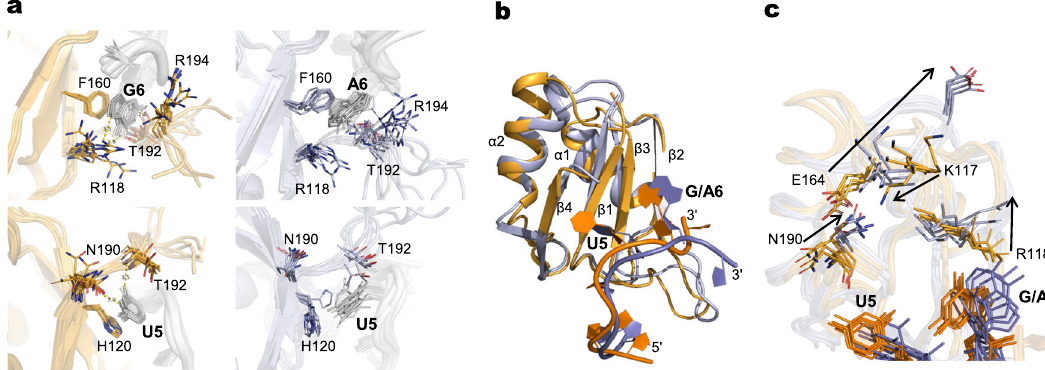
Fig. 6 | Comparison of RbFox RRM structures with 5 ’ -UGCAUGU and 5 ’ - UGCAUAU. a Recognition of G6/A6 (upper panel) and U5 (lower panel) by RbFox RRM (left: 5 ’ -UGCAUGU; right: 5 ’ -UGCAUAU). Side chains of key residues in the interactions (sticks) are labeled. b Comparison of the two RbFox-RNA structures